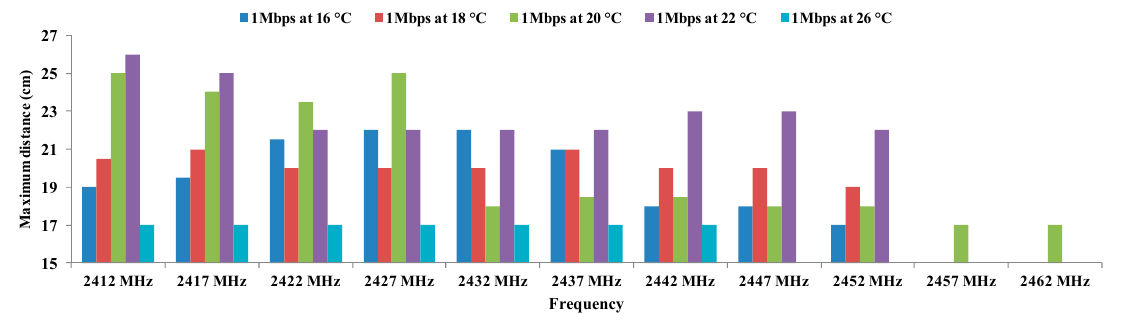
Figure 8. Maximum distances for BPSK.